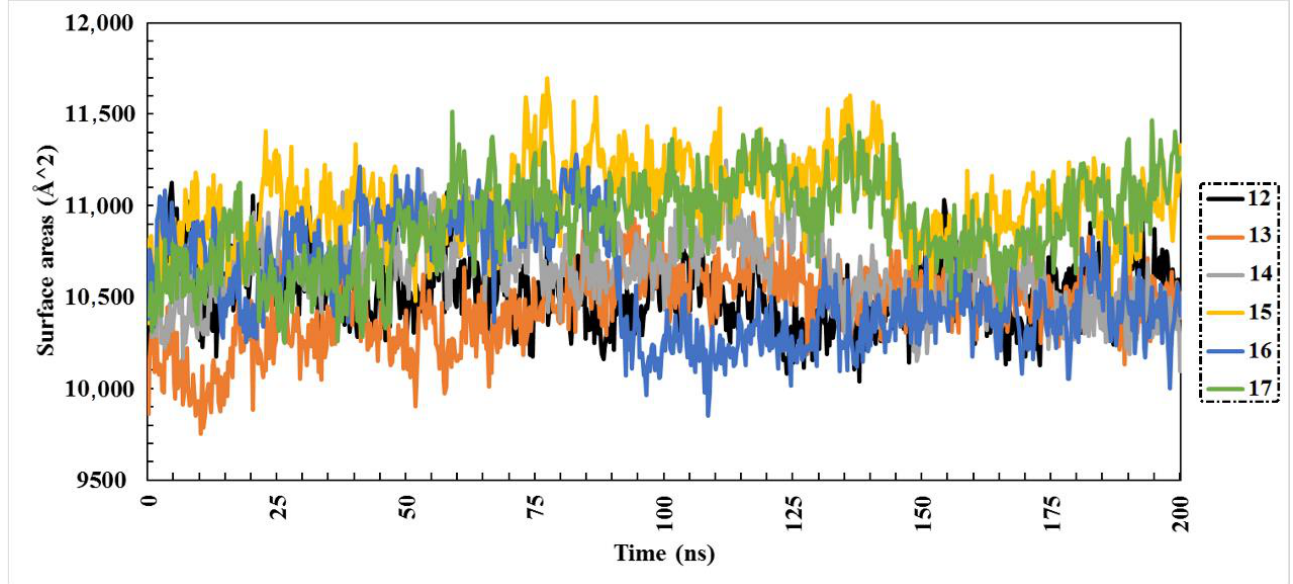
Figure 6 . Solvent-accessible surface area (SASA) of the best six compounds for 200 ns MD simula- tions. Table 2. Predicted physiochemical parameters of the best identified compounds and their structural